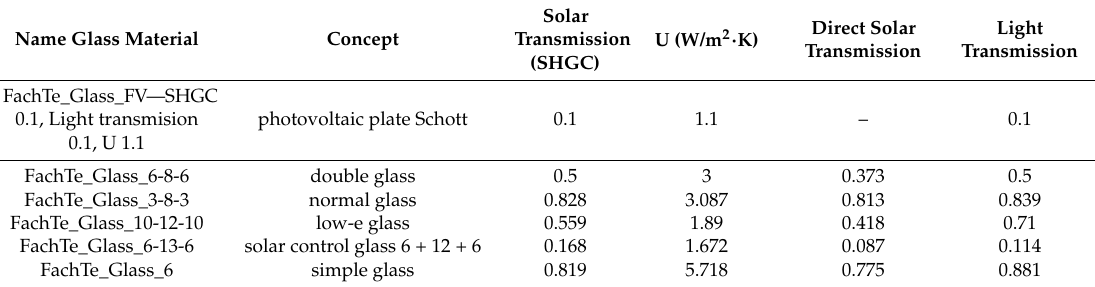
Table 2. Glass materials used in the simulation models. Source